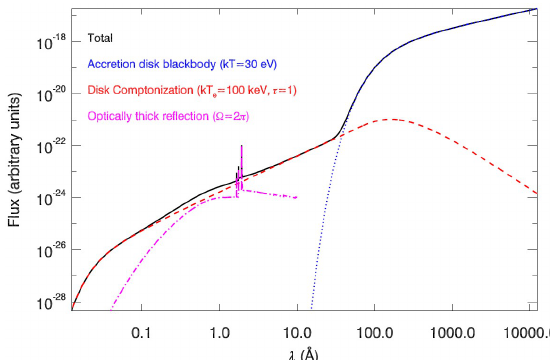
Figure 1: Schematic view of an AGN intrinsic UV- to-X-ray spectrum. Blue : thermal emission from a lu- minous accretion disk with a temperature at the inner- most radius of 30 eV; red : unsaturated Comptonisation of soft disk photons with kT e =100 keV and τ es =1; ma- genta : reflection from a plane-parallel infinite slab of cold ( ∼ 10 4 K) matter (Compton continuum plus Fe and Nickel K α and K β fluorescent emission lines; after Nan- dra et al.